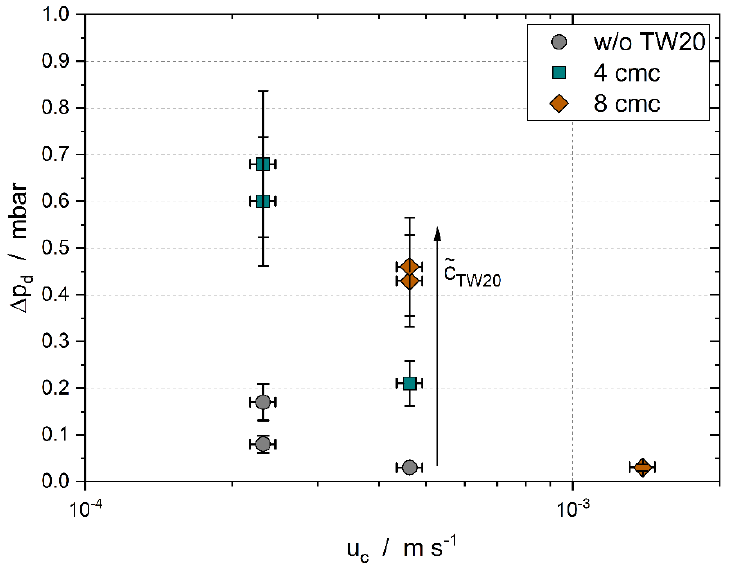
Figure 13. Differential pressure ∆ p d needed to inoculate the liquid droplet after it came into contact with the solid particle with (4 or 8 cmc ) and without ( w / o ) TW20 as the surfactant. ∆ p d correlates linearly with the force needed for CMN due to the flow field (Equation (6)).